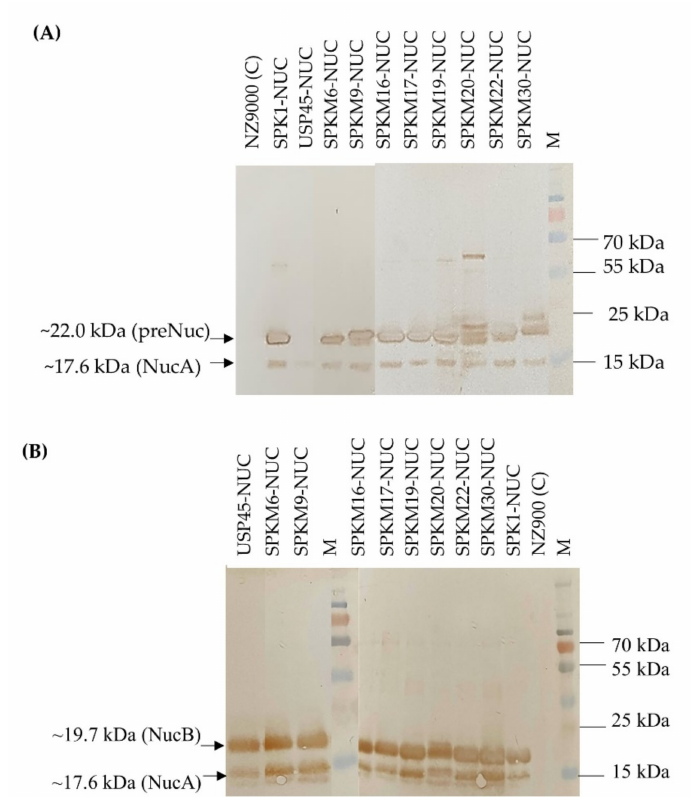
Figure 3. Western blotting analysis showing ( A ) intracellular fraction and ( B ) extracellular fraction of recombinant NUC protein produced by recombinants L. lactis harbouring different signal peptide constructs at 4 h expression with 40 ng/mL of nisin induction (unedited western blot is shown in the supplementary data, Scheme S1).